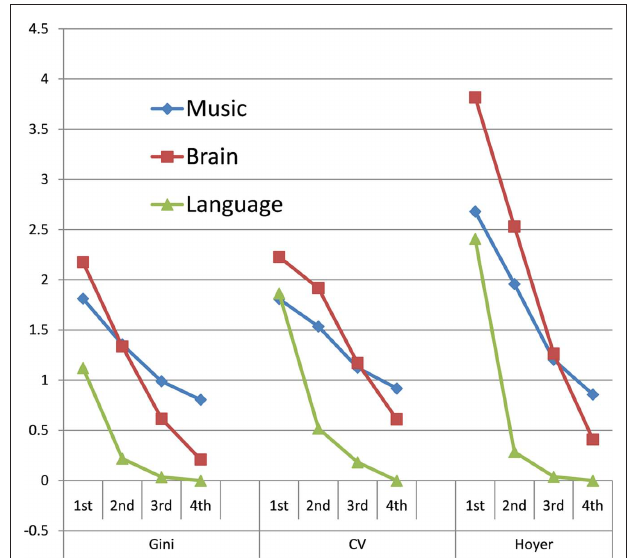
FIguRe 4 | Normalized Sparseness measures for music, brain data, and language (median values). Single symbols (first order), pairs (second), triples, and quadruples and compared, as calculated with the Gini coefficient, the coefficient of variation, and the Hoyer index. For 10 of the 12 separate observations, the greatest similarity is between brain data and music. In all cases, brain data are more similar to music than they are to language, as measured by Wilcoxon rank sum probabilities